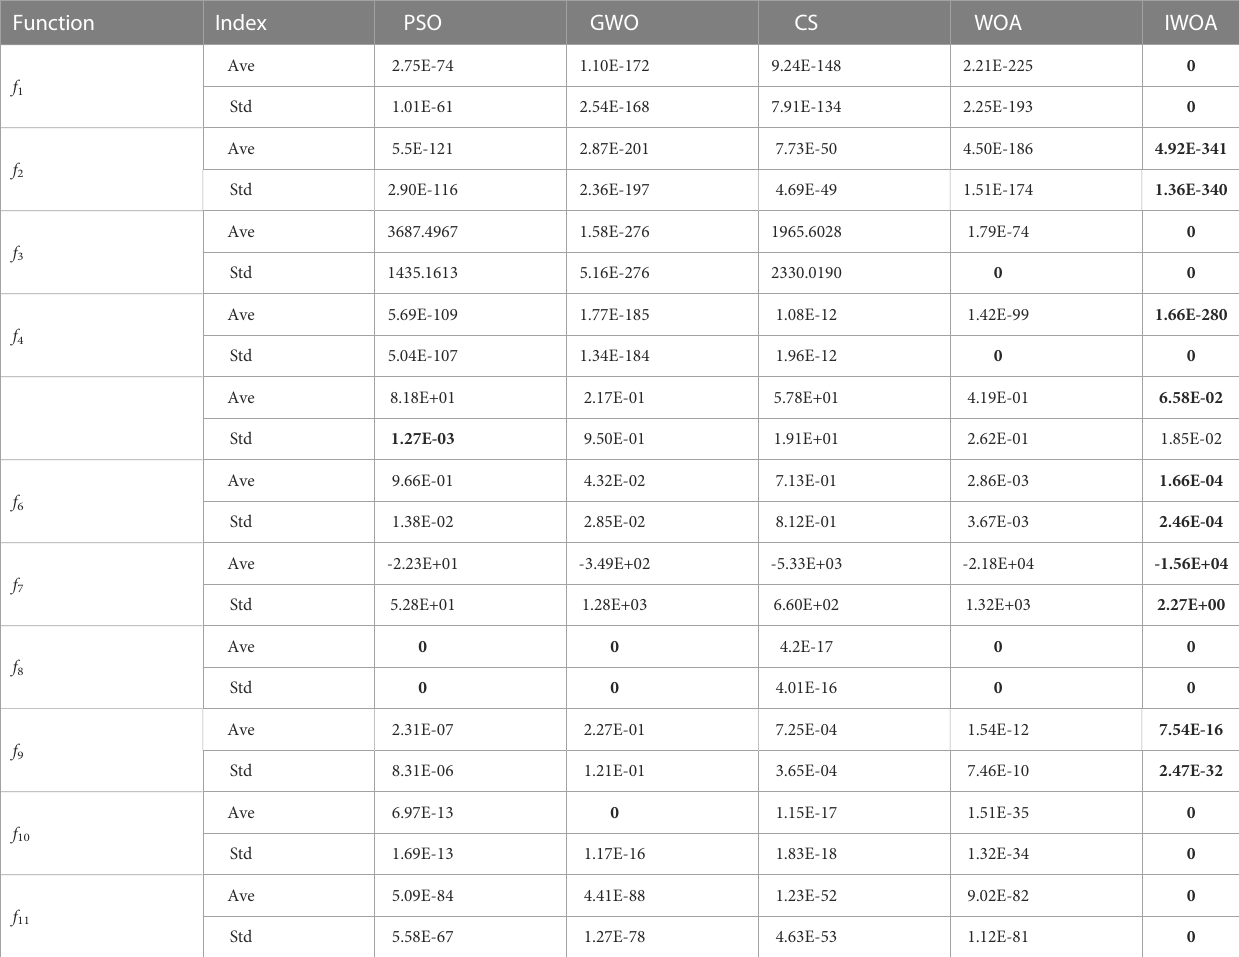
TABLE 2 Experimental results of different optimization algorithms.